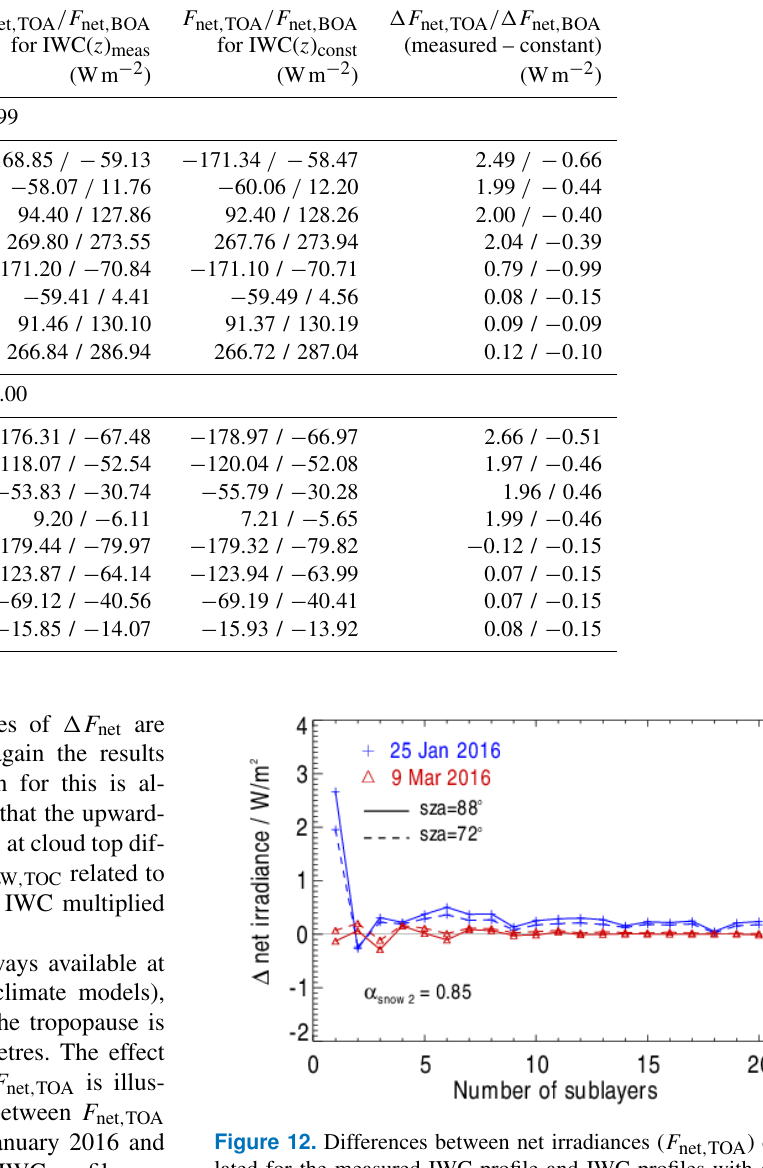
Table 2. Net irradiances at the top of the atmosphere and at the surface ( F net , TOA and F net , BOA respectively) calculated for measured and vertically constant profiles of the ice water content (IWC( z ) meas and IWC( z ) const respectively). (cid:49)F net is the difference of F net (IWC meas ) minus F net (IWC const ). Results are selected for four solar zenith angle (sza) values and for the days 25 January and 9 March 2016.